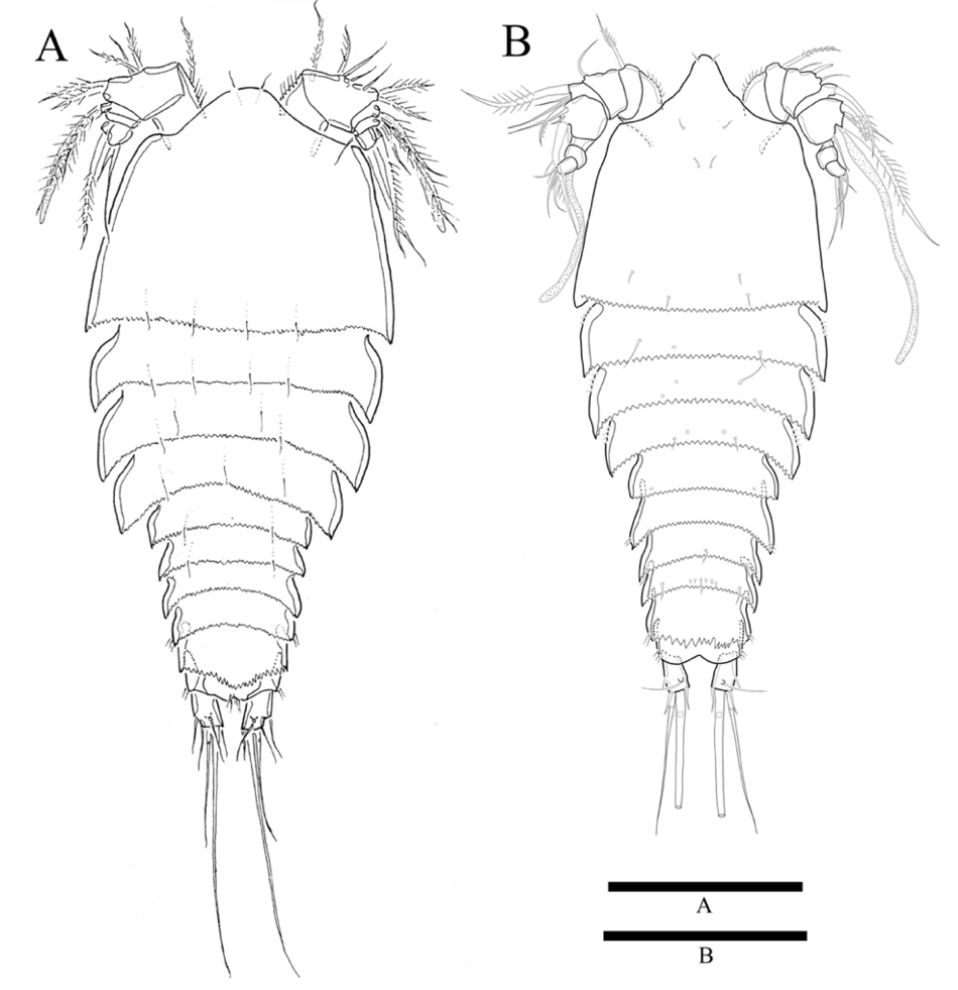
Figure 6. Zosime thistlei sp. nov. ( A) Habitus of female, dorsal; ( B ) Habitus of male, dorsal. Scale bars: 100 µm . Description of Female . Total body length of holotype 328 µm (measured from anterior margin of rostrum to posterior margin of caudal rami). Largest width (184 µm) measured at posterior margin of cephalic shield. Urosome distinctly narrower than prosome (Figure 6A).